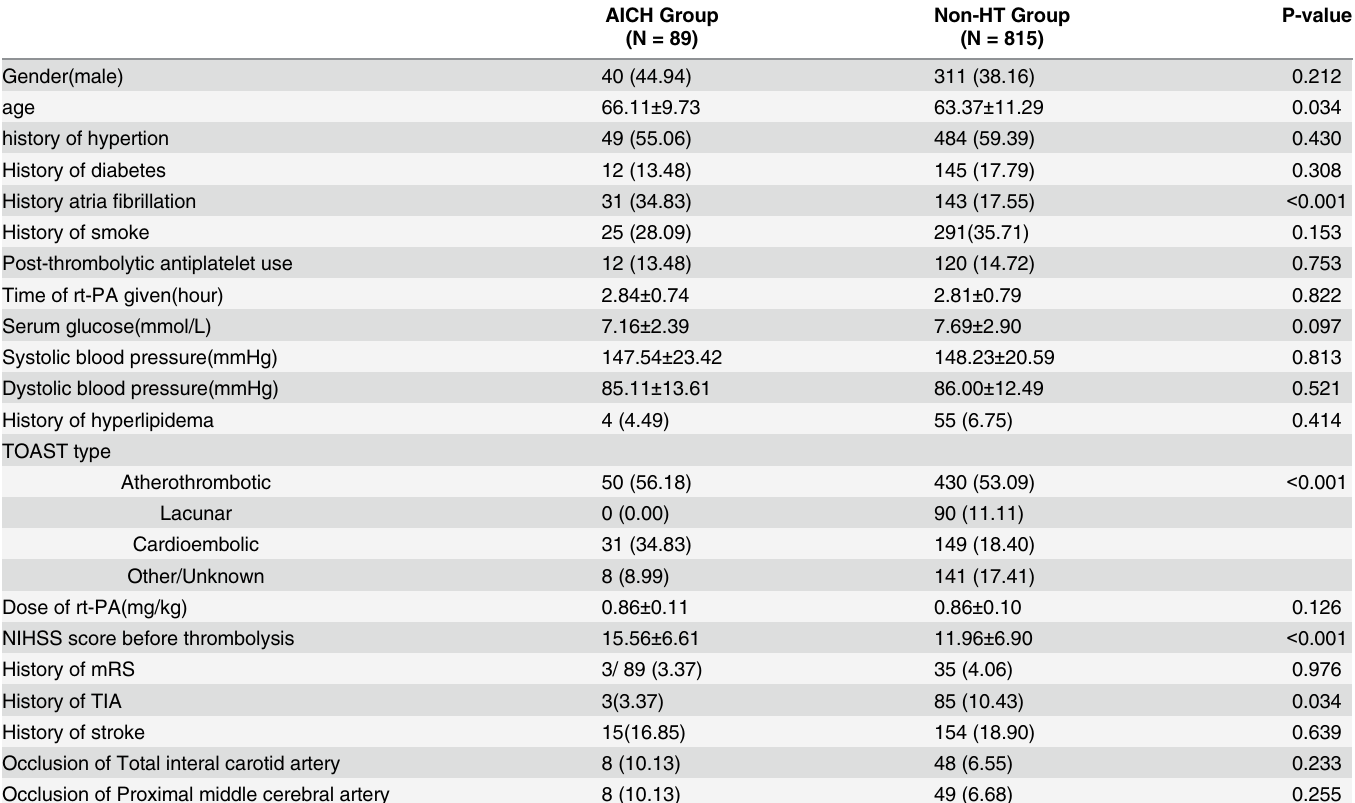
Table 1. Baseline characteristics of patients between AICH and no HT after thrombolysis.